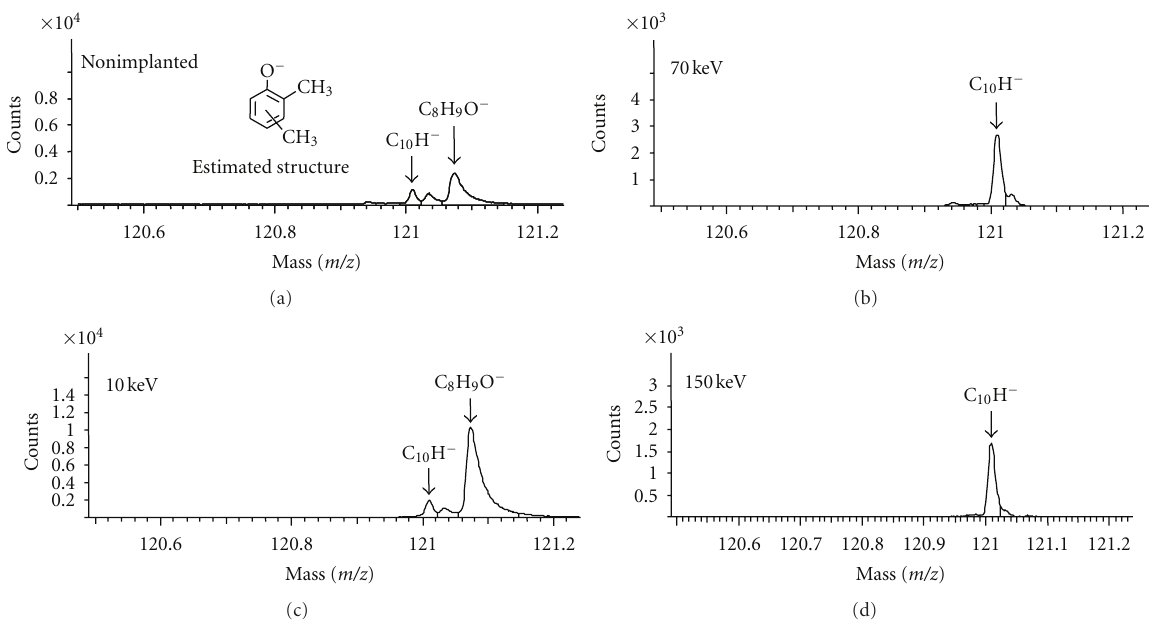
Figure 7: The second negative ion mass spectra of ion-implanted resists with various acceleration energies.